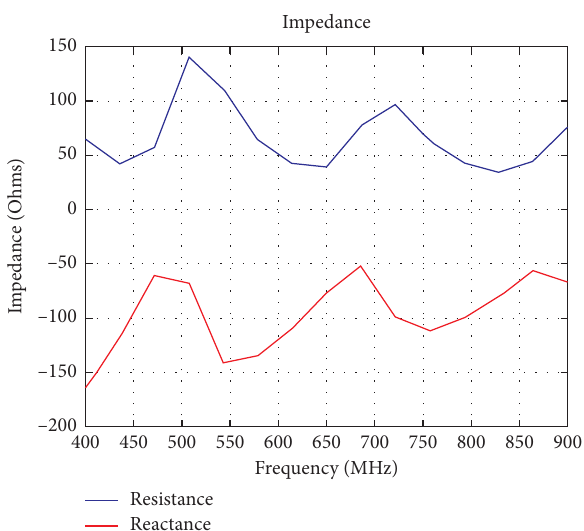
Figure 9: Dipole’s impedance along the bandwidth.